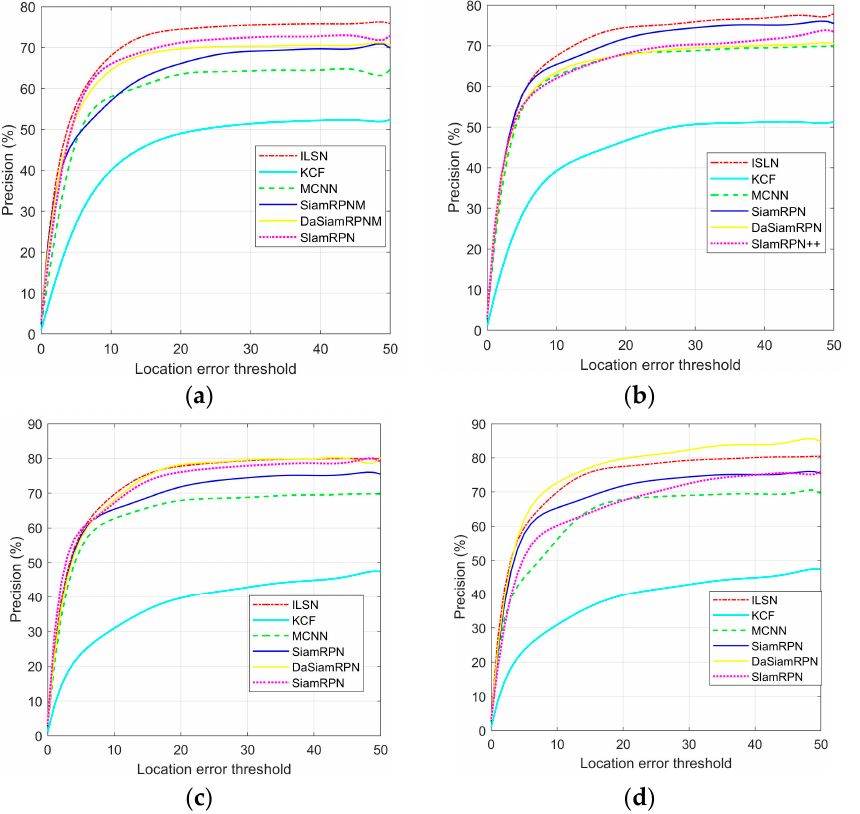
Figure 6. Accuracy comparison of the UAV123 dataset under 4 different scenarios. ( a ) Background clutters; ( b ) Partial occlusion; ( c ) Background clutters; ( d ) Similar object. Table 4. Results of the comparative experiment under 4 different